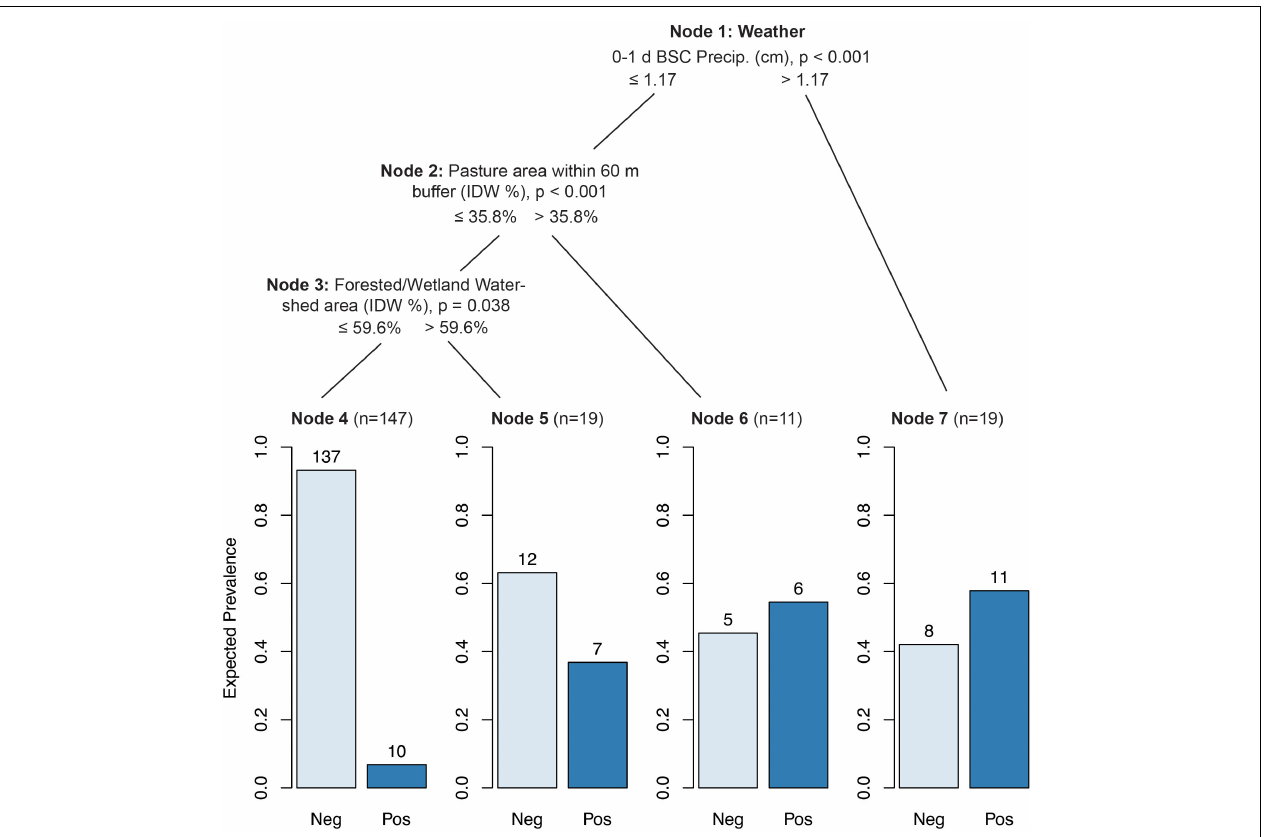
FIGURE 3 | Conditional inference tree (CTree) showing factors and combinations of factors predictive of Rum2Bac (ruminant) marker presence. In Node 1, 0–1 d BSC precipitation was designated the primary split ( p < 0.001), while E. coli (split = 2.8 log 10 MPN/100 ml, p < 0.008), average solar radiation in the 0–1 d BSC (split = 0.43 MJ/m 2 , p < 0.008), and turbidity (split = 1.30 log 10 NTUs, p < 0.056) were designated surrogate splits that split the data equally well. Nodes 2 and 3 had no significant